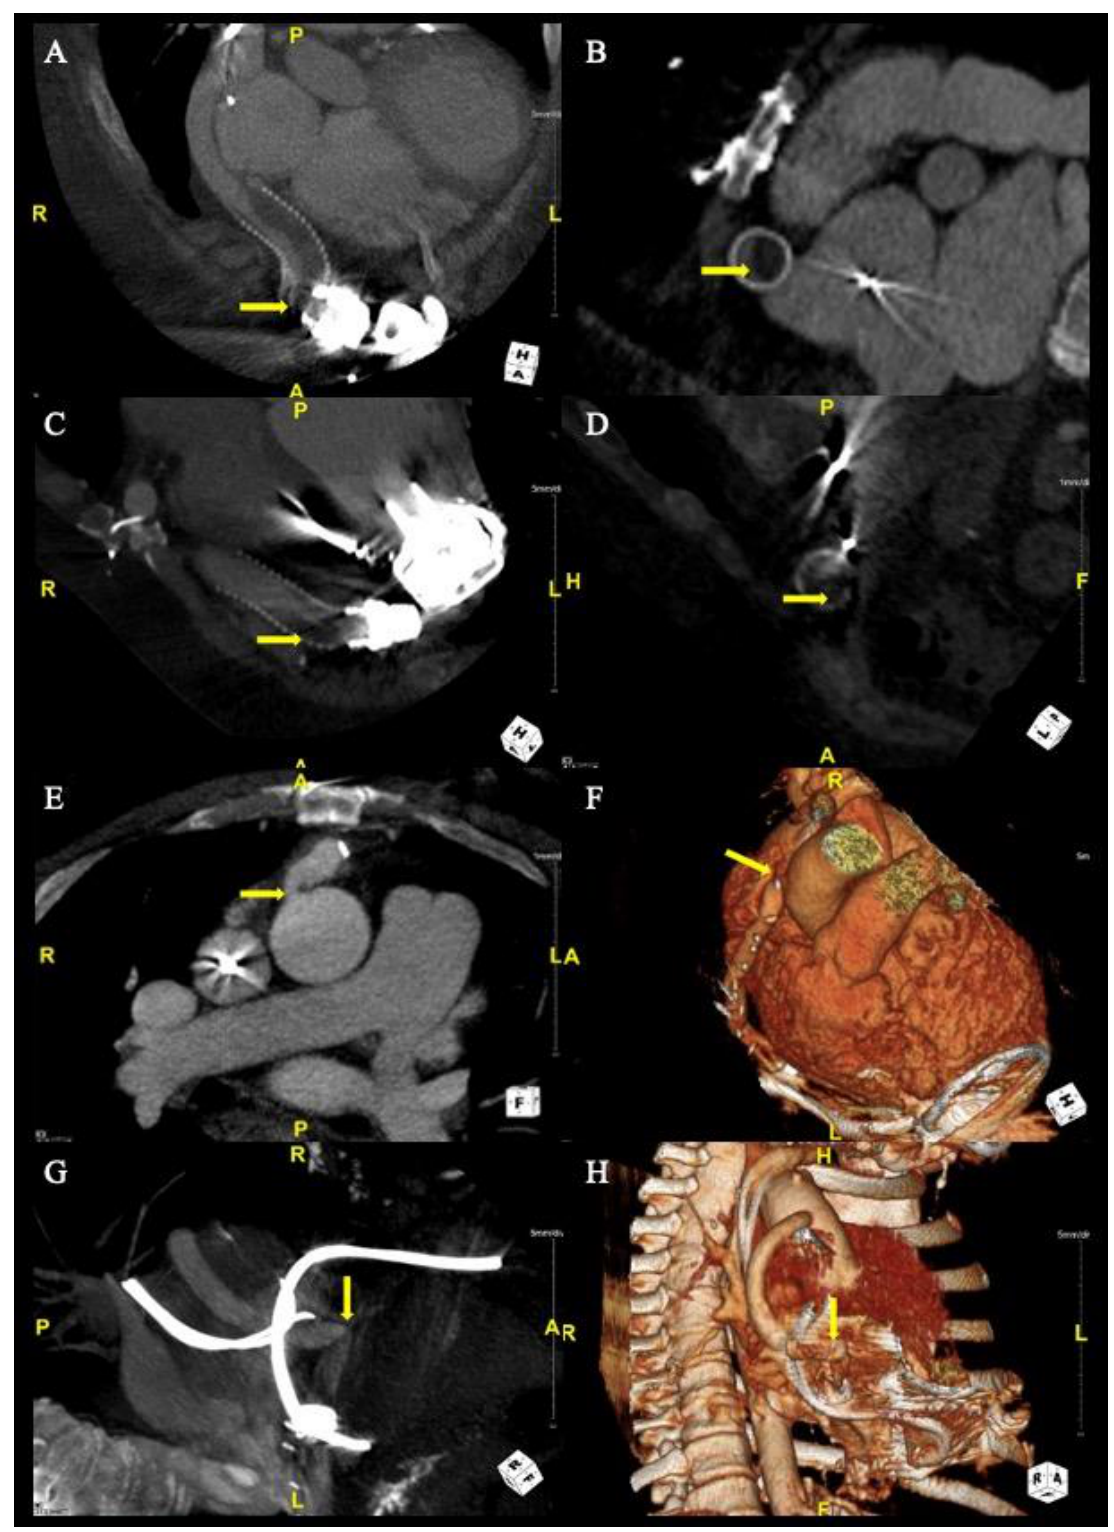
Figure 1. Computed Tomography Angiography of Obstructions. For case 1, CTA (Panel A ) demon- strates stenosis with bend relief disconnect and CTA (Panel B ) demonstrates a partially occlusive thrombus. For case 5, CTAs (Panel C,D ) demonstrate partially occlusive thrombus. For case 8, CTAs (Panel E,F ) demonstrate ascending aorta anastomotic stenosis. For case 11, CTAs (Panel G,H ) demonstrate outflow cannula kink.